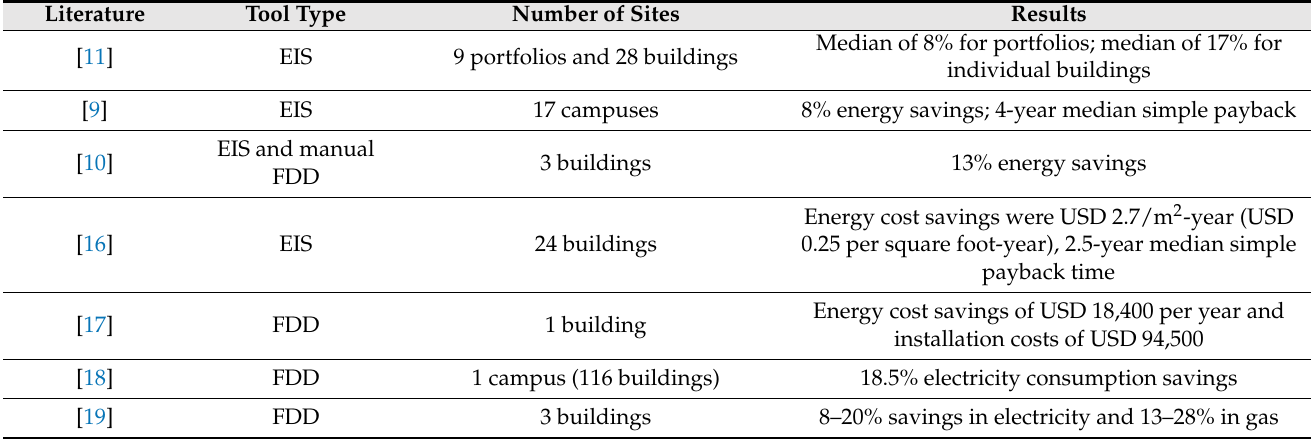
Table 1. Case studies that present results of savings, technology costs, and simple payback